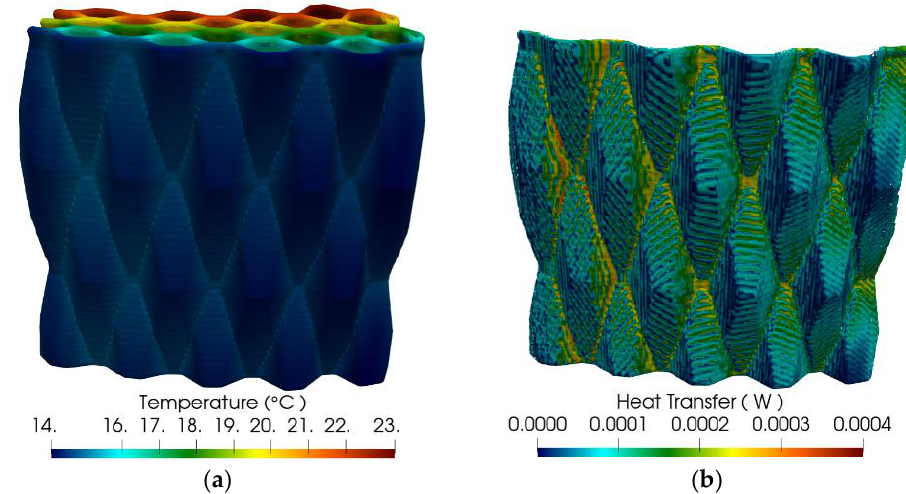
Figure 11. Three-dimensional simulation results on the existing prototype showing ( a ) the temper- ature field and ( b ) the heat flux on the outer surface.